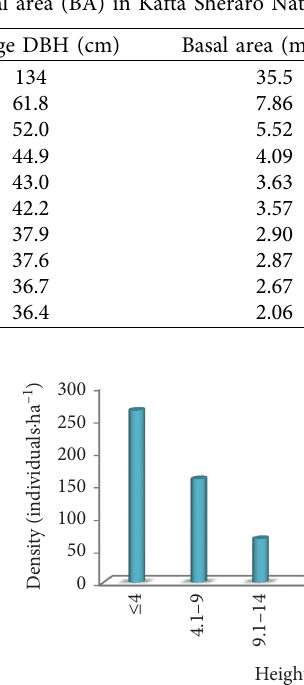
Figure 5: Pattern of basal area (m 2 · ha − 1 ) along altitudinal dif- ference (m) in Kafta Sheraro National Park (KSNP).